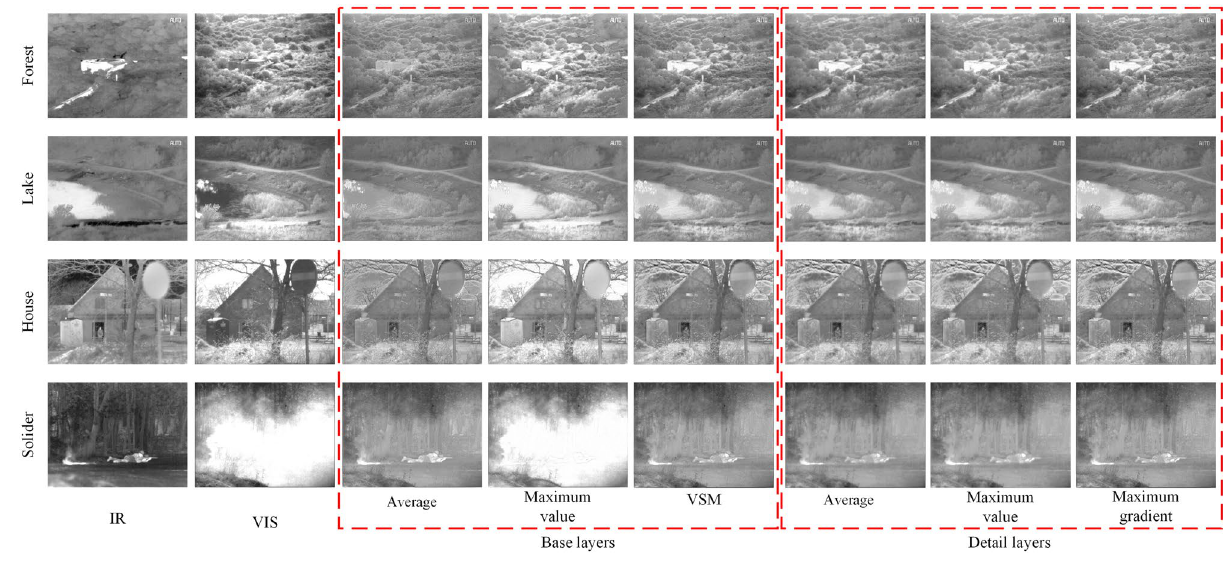
Figure 7. Influence of fusion strategy on result.